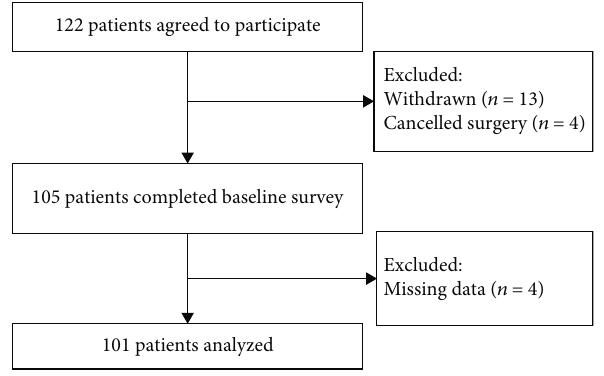
Figure 1: Study fl ow